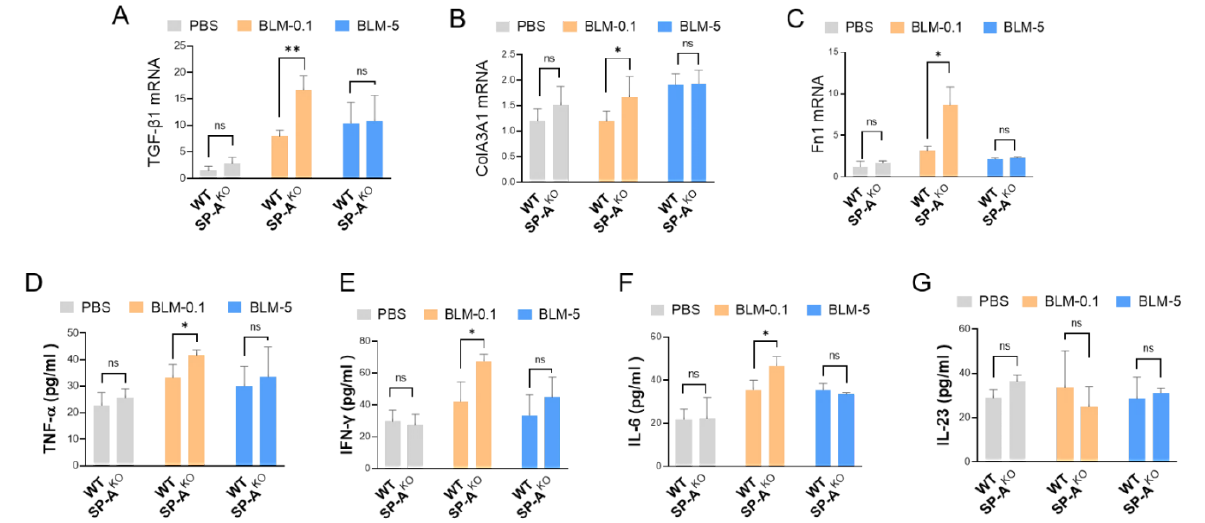
Figure 4. SP-A loss enhances the upregulation of fibrosis-associated genes and proinflammatory cytokines in the lungs of mice induced with a low dose of BLM. ( A – C ) The mRNA expression levels of TGF-β1 ( A ), Col3A1 ( B ), and Fn1 ( C ) in lung tissues of SP-A-deficient mice challenged with BLM (5 mg/kg BLM or 1 mg/kg BLM) were analyzed by quantitative real-time PCR. The relative level of these proteins was normalized to that of β-actin and calculated as fold change compared to those in PBS-treated WT group. ( D – G ) ELISA analysis of proinflammatory cytokines, such as TNF-α ( D ), IFN- γ ( E ), IL-6 ( F ), and IL-23 ( G ), in the lung tissues of SP-A-knockout mice following BLM administration. The data are presented as the mean ± SE. * p < 0.05, ** p < 0.01. ns indicates no significant difference between groups. WT group: control lentivirus-injected mice; SP-A KO group: lentivirus targeting SP-A-injected mice; BLM-0.1: 0.1 mg/kg BLM-induced mice; BLM-5: 5 mg/kg BLM-induced mice. n = 3–9 per